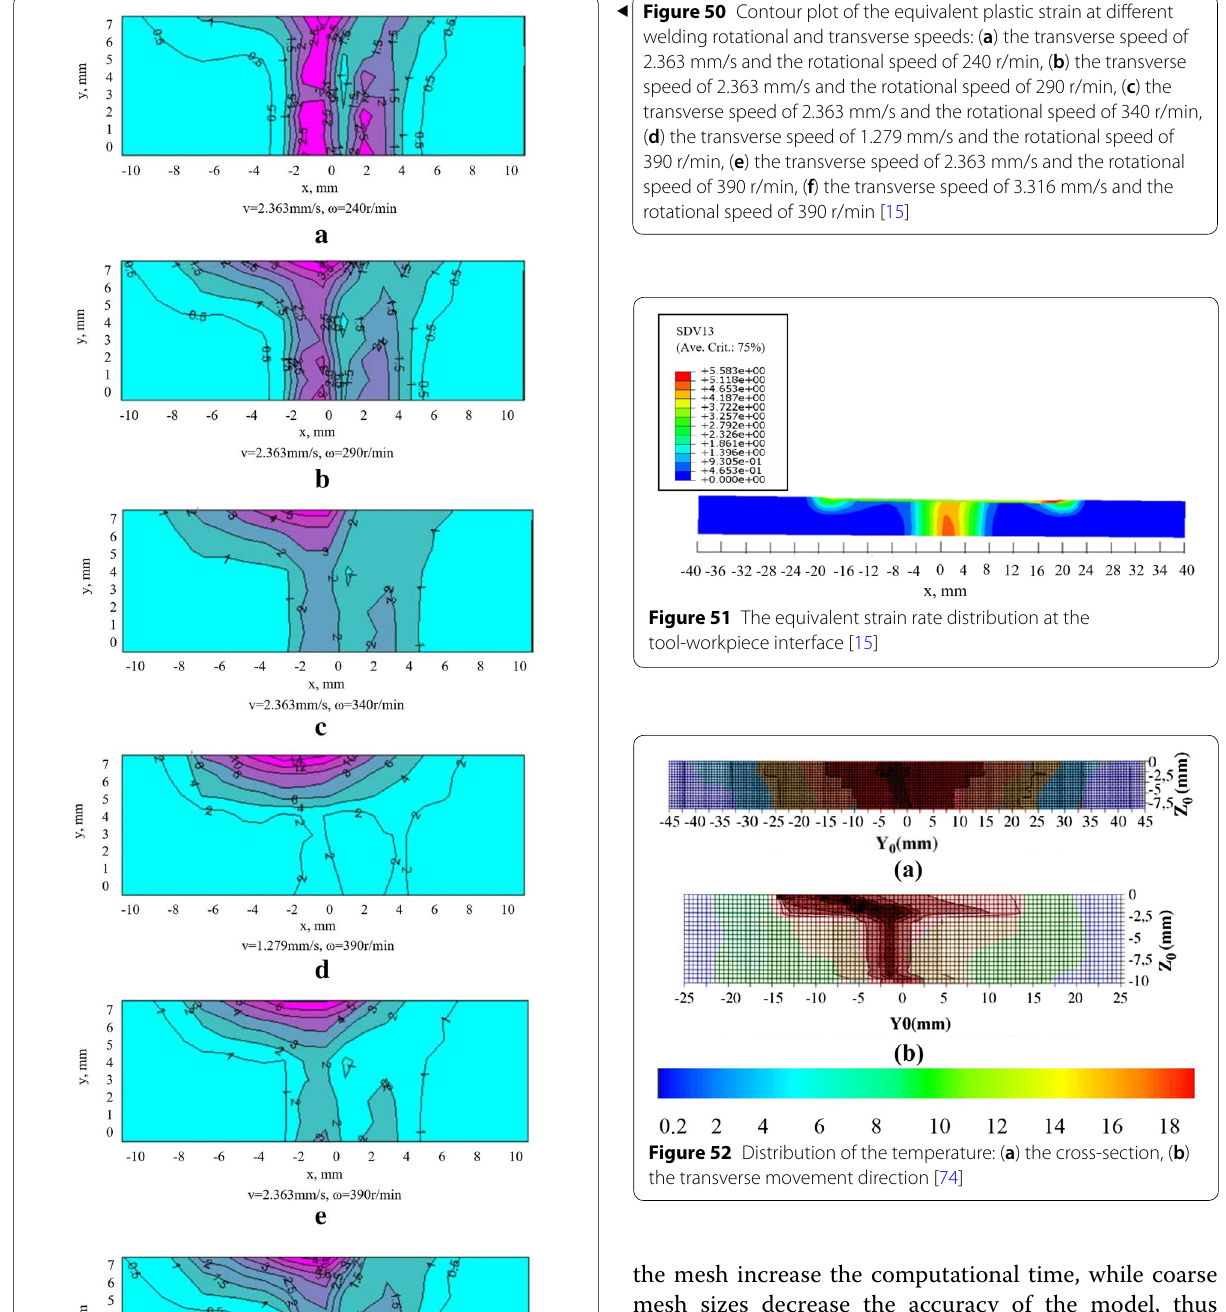
the mesh increase the computational time, while coarse mesh sizes decrease the accuracy of the model, thus for an accurate and appropriate simulation, optimized mesh size should be considered. Furthermore, the maxi- mum value of the equivalent strain rate is reported to be around 6.